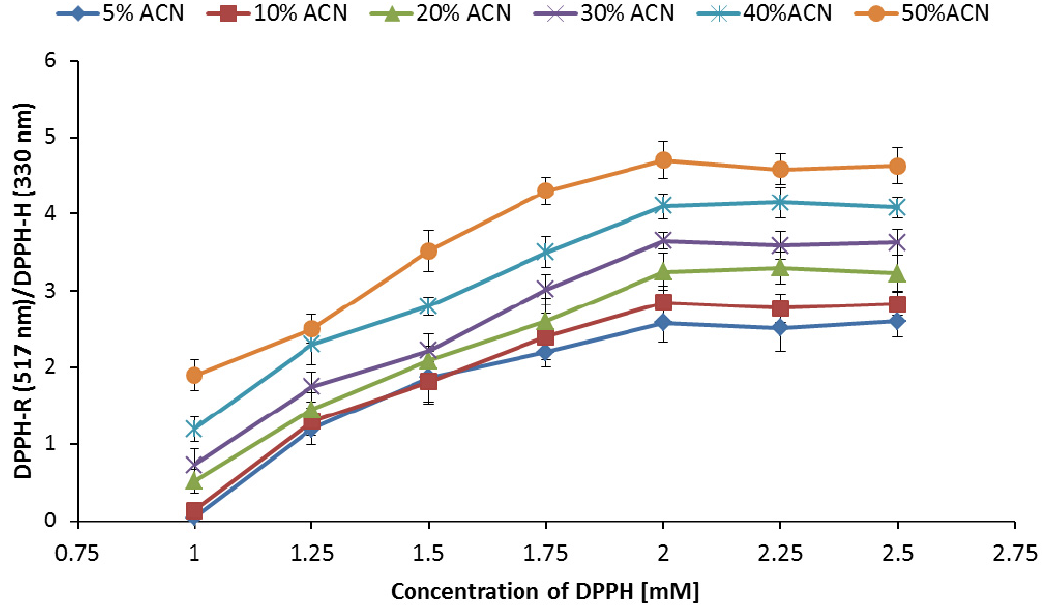
Figure 4. Effect of DPPH concentration on the DPPH-R/DPPH-H peak area ratio obtained using gradient modes starting with 5% ACN, 10% ACN, 20% ACN, 30% ACN, 40% ACN, and 50% ACN. The chromatograms were monitored at 330 nm (DPPH-H) and 517 nm (DPPH-R).